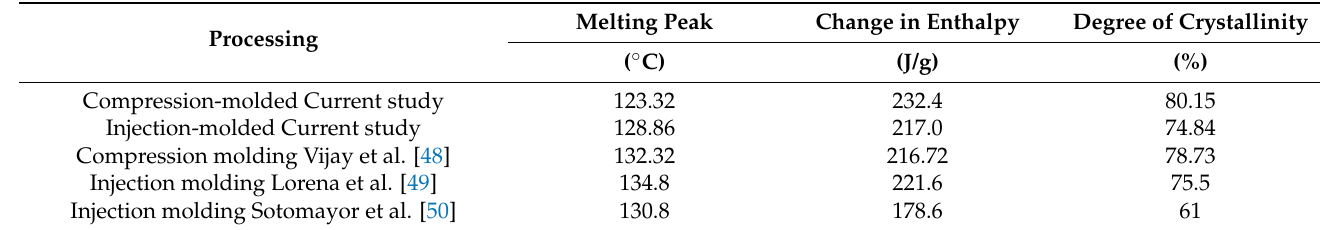
Table 3. DSC results for both processing